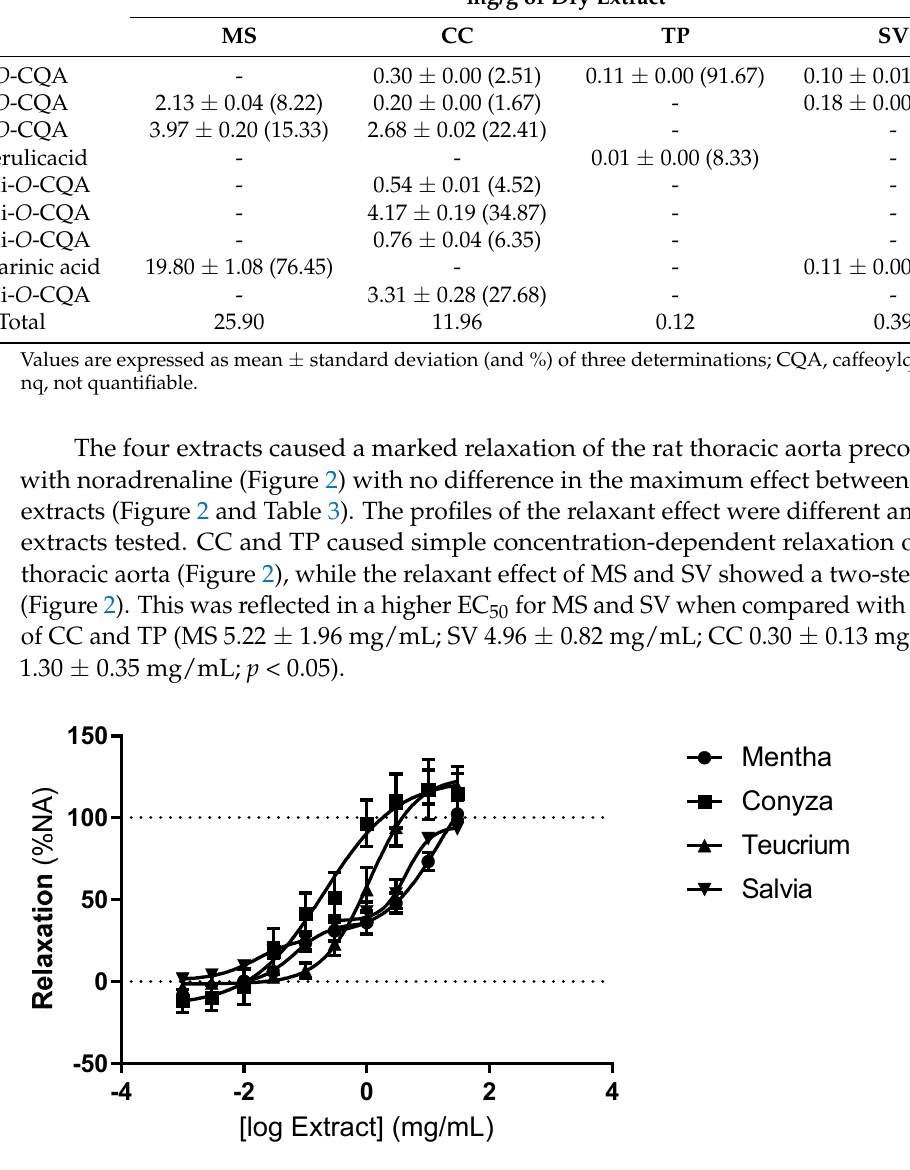
Figure 2. Concentration-response curves of the relaxant effect of the extracts of M. suavoelens (MS; circle), C. canadensis (CC; square), T. polium (TP; triangle) and S. verbenaca (SV; inverted triangle) on the rat thoracic aorta. Results expressed as % of the contraction induced by noradrenaline 5 µ M. n = 5–7 rats in each group. Table 3. Maximum relaxant effect (Emax; %NA) for the four extracts in the absence (control condition) and in the presence of L ‐ NAME 100 μ M, Atropine 6 μ M or Indomethacin 10 μ M, on the rat thoracic aorta.